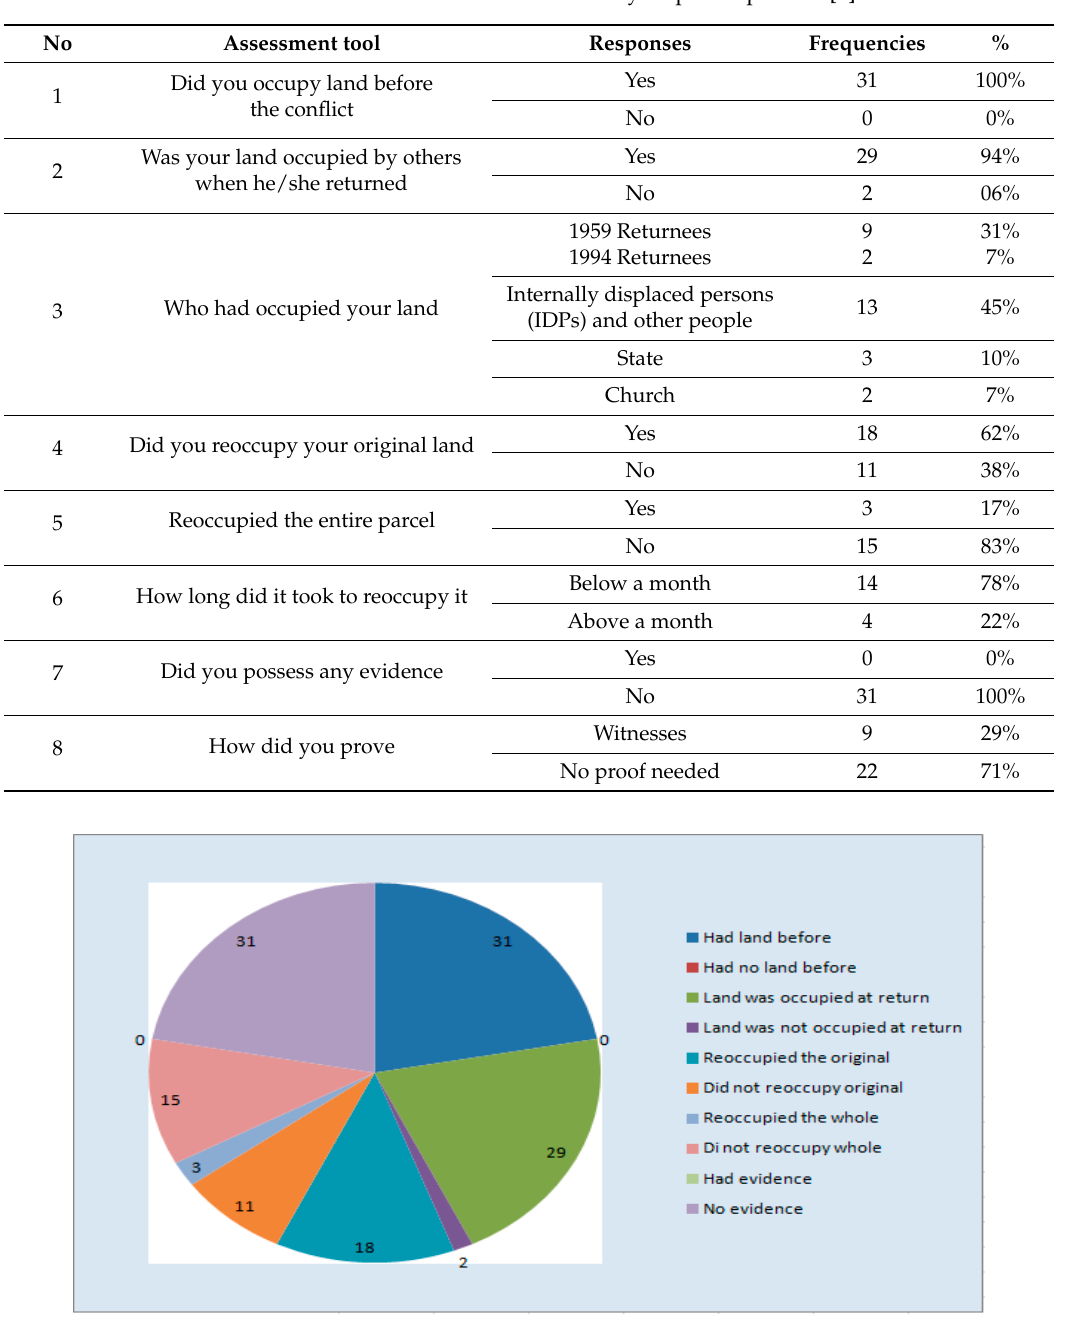
Figure 1. Repossession of land in post-conflict Rwanda.